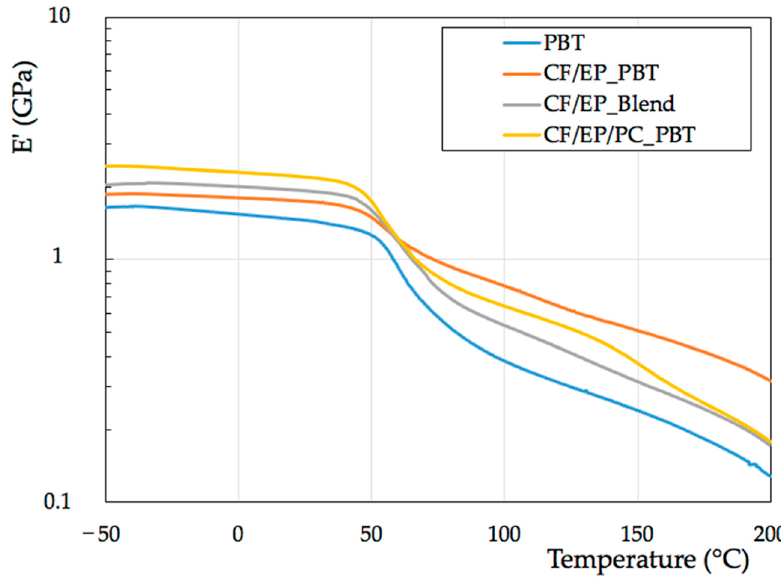
Figure 3. Elastic modulus (E ′ ) of the investigated materials.